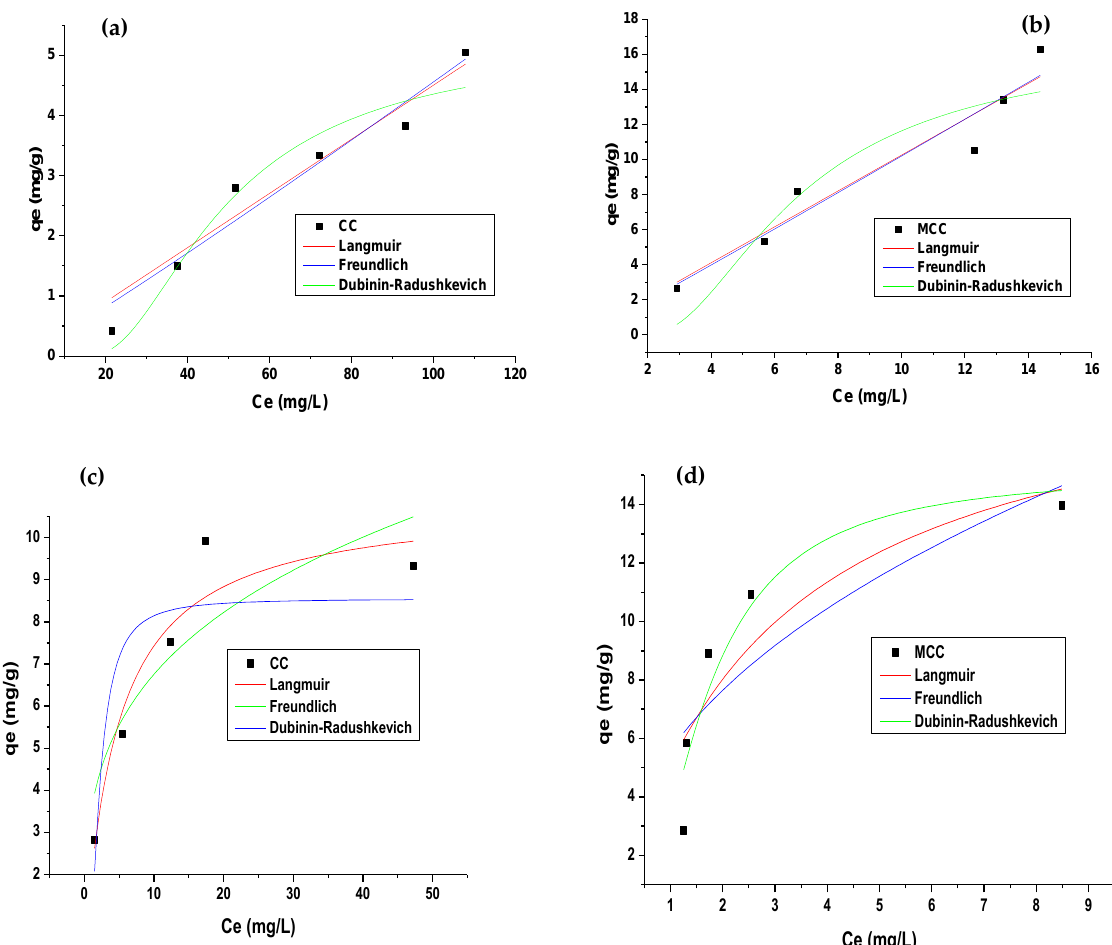
Figure 5. Fitting to adsorption isotherm models of ( a ) tartrazine on CC, ( b ) tartrazine on MCC, ( c ) Congo Red on CC and (d) Congo Red on MCC, at pH 4, 30 °C and 5 mg/L of adsorbent dose.